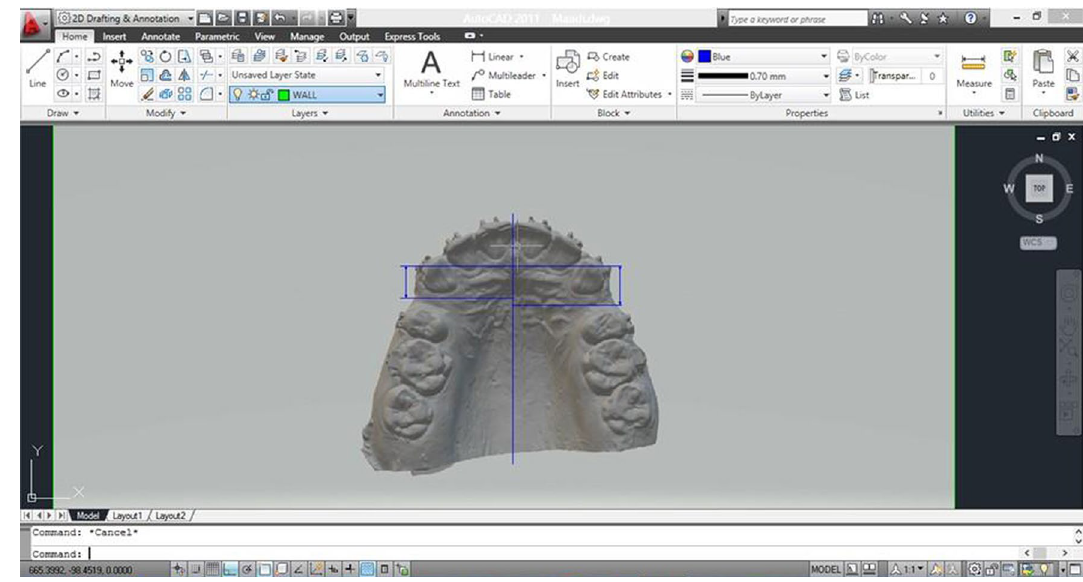
Figure 4. Measurement of canine retraction using